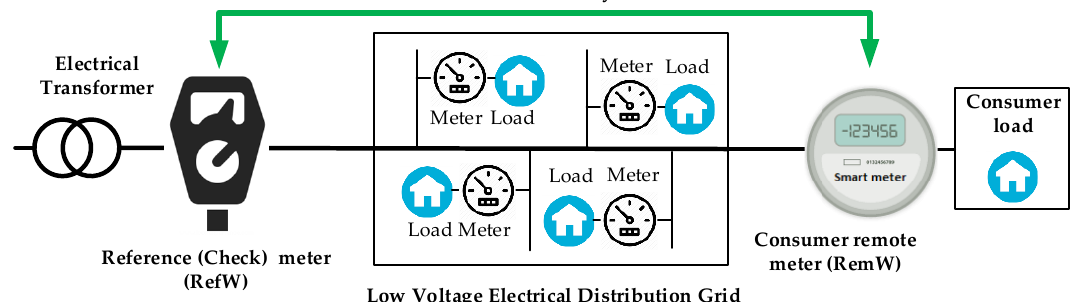
Figure 2. Method for remote verification of electrical energy smart meters [3].